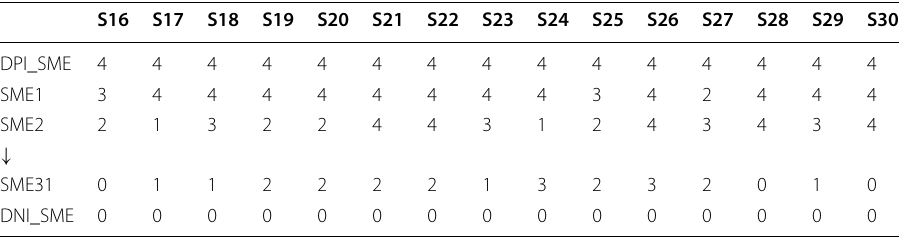
Table 9 Comparative number of non-financial data converted using Likert